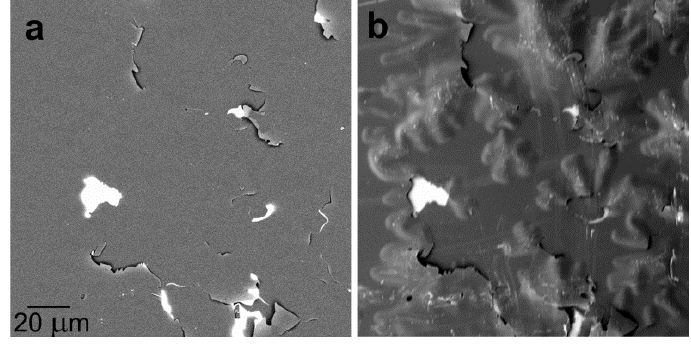
Figure 24. Delaminated 200 nm CN sample in 1 kV/mm field. ( a ) BSE at 4 keV; ( b ) BSE at 500